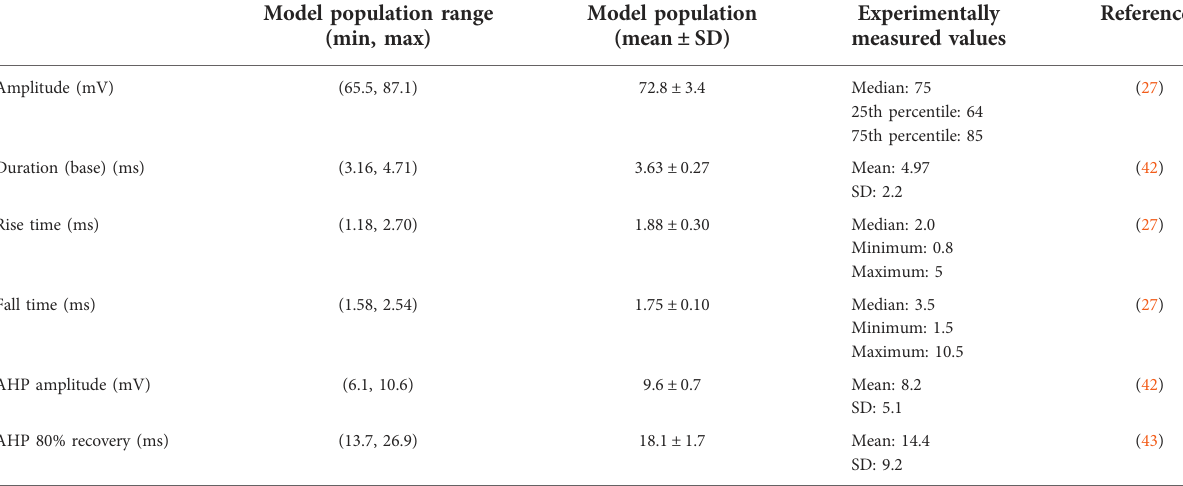
TABLE 1 Model and experimental ranges for somatic action potential validation